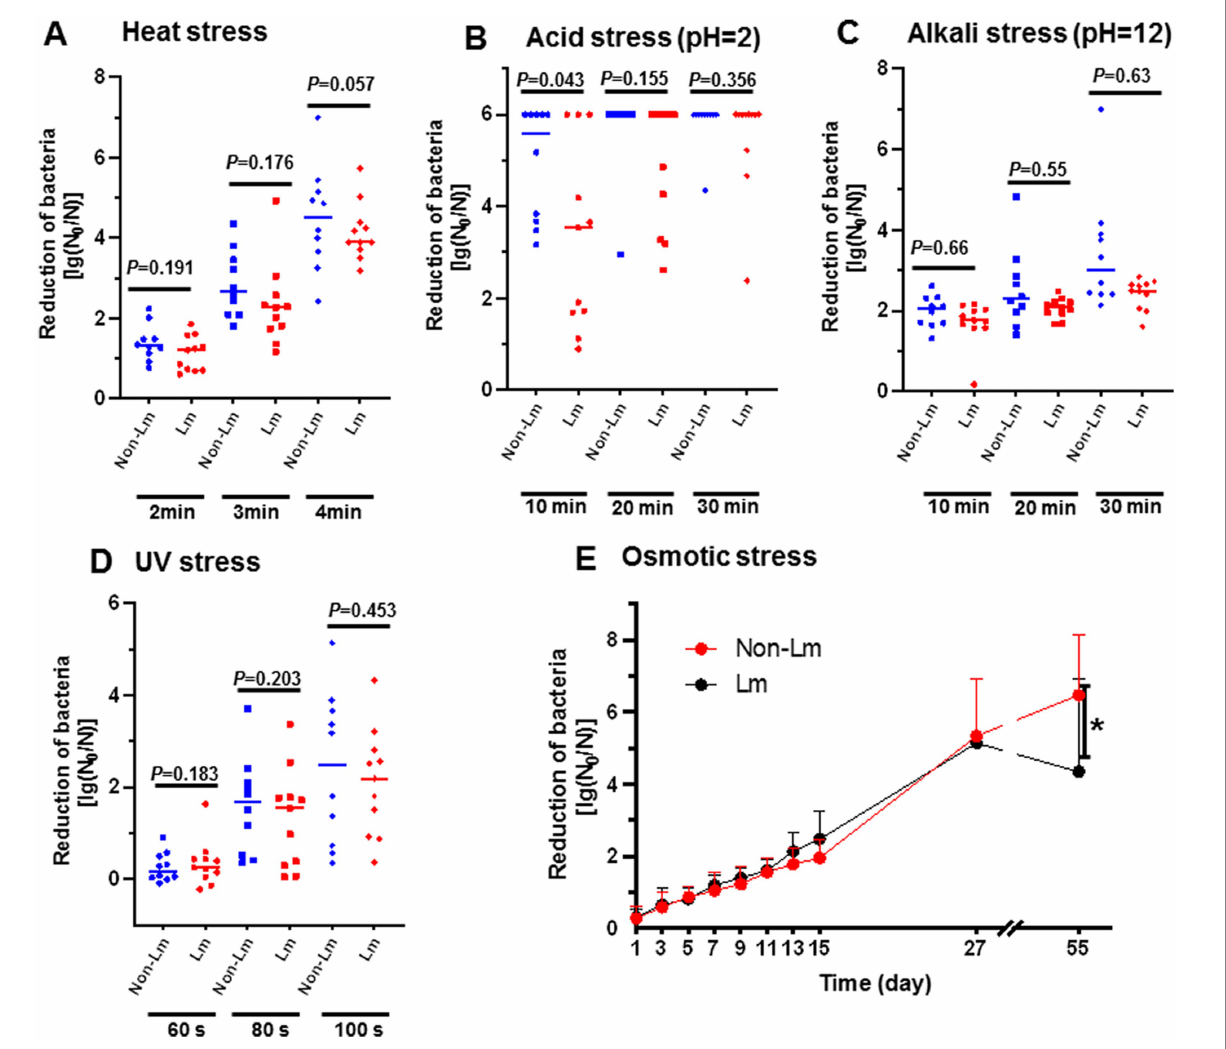
FIGURE 1 Effect of various stress conditions on survival of L. monocytogenes (Lm) isolates and non- L. monocytogenes (non-Lm) isolates. Reduction of bacteria was calculated as log(N 0 /N), N 0 = colony forming unit of organisms before exposure to stress, N = colony forming unit of organisms after exposure to stress. (A) Bacterial survivability under heat stress. The logarithmic reduction value showed bacterial numbers of (non-Lm) and (Lm) strains in response to heat stress at 65 ° C for 2 min, 3 min, and 4 min. (B) Bacterial survivability under acid stress. The logarithmic reduction value showed bacterial numbers of (non-Lm) and (Lm) strains were treated with acid stress (pH 2.0) for 10 min, 20 min, and 30 min. (C) Bacterial survivability under alkaline stress. The logarithmic reduction value showed bacterial numbers of (non-Lm) and (Lm) strains treated with alkaline stress (pH 12.0) for 10 min, 20 min, and 30 min. (D) Bacterial survivability under UV stress. The logarithmic reduction value showed bacterial numbers of (non-Lm) and (Lm) strains under UV stress for the 60s, 80s, and 100 s. (E) Bacterial survivability under osmotic stress. The logarithmic reduction value showed bacterial numbers of (non-Lm) and (Lm) strains were under 10% NaCl stress for 55